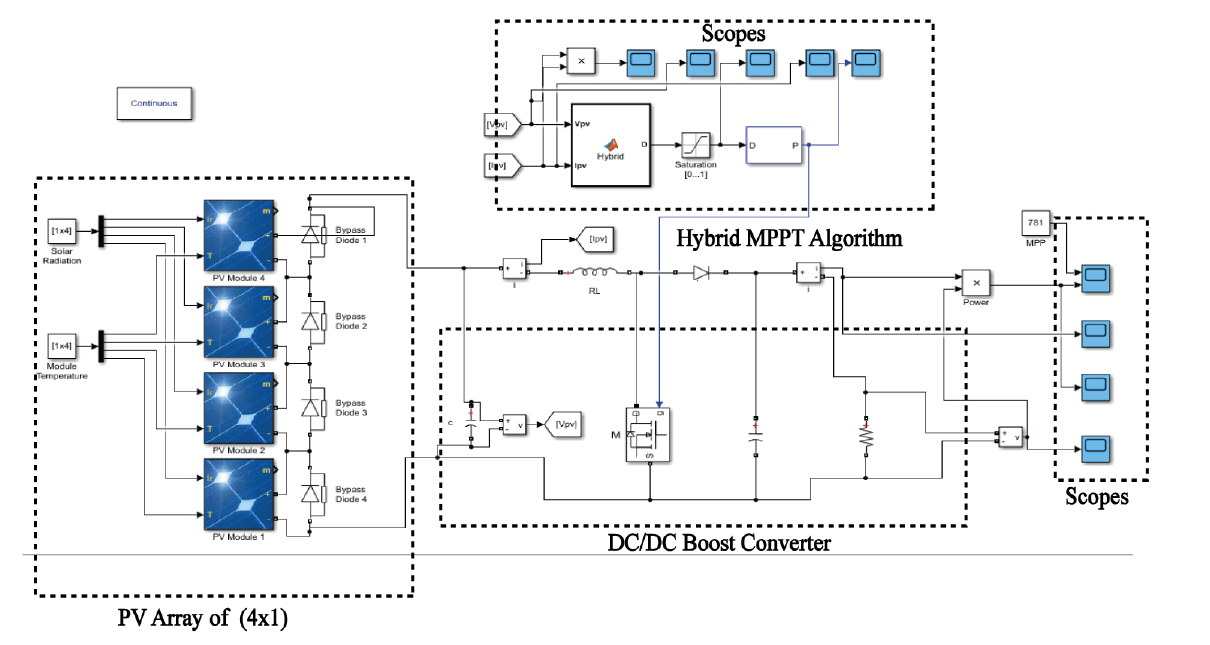
Figure 9. Simulation